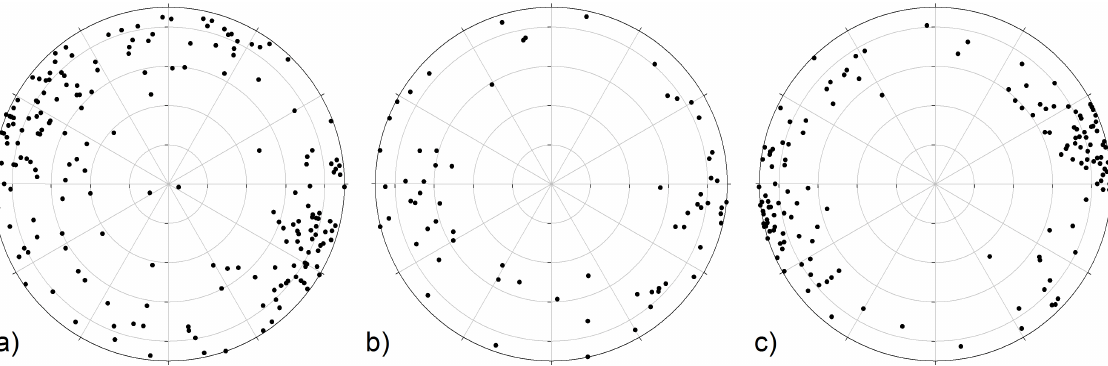
Fig. 6. Schmidt equal-area diagrams for the c-axes of horizontal thin sections. (a) a total of six thin sections from IW-26 ( n = 199) showing horizontal girdle with 1 maximum, (b) a total of two thin sections from ISW-28 ( n = 70) showing horizontal girdle, (c) a total of five thin sections from IW-28 ( n = 150) showing horizontal girdle with 1 maximum. Table 1. Summary of results and comparison between IW-26, ISW-28 and IW-28. Values shown are minimum–maximum, mean. IW-26 ISW-28 IW-28 Crystal area range (mm 2